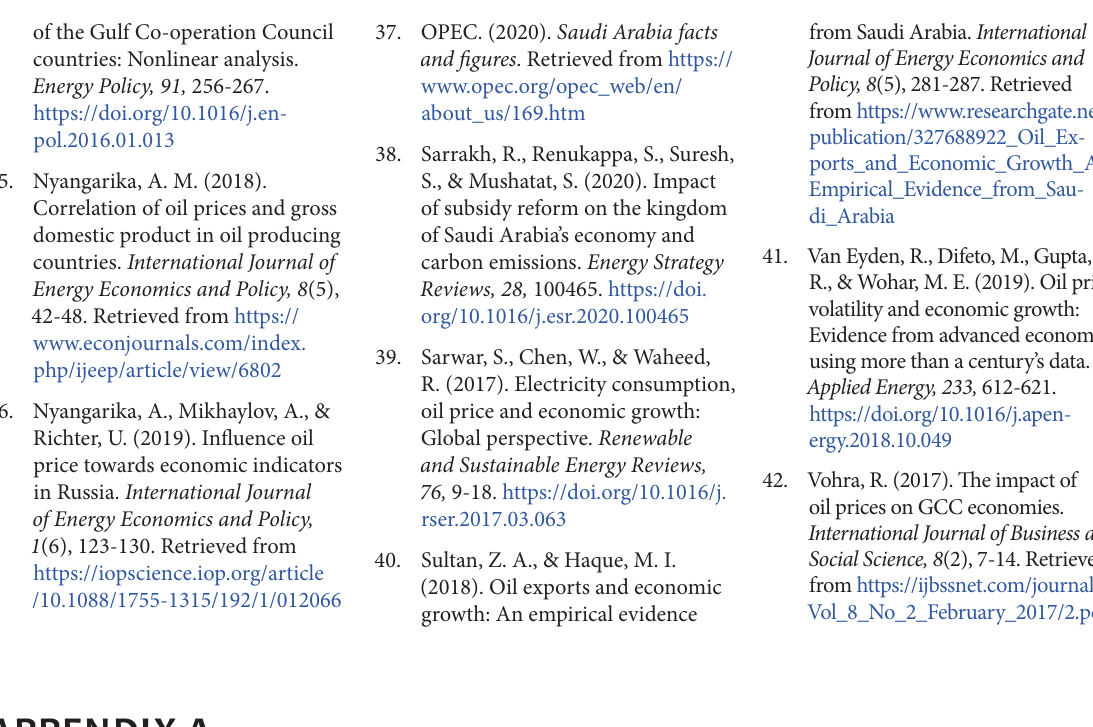
Table A1. FBI of oil prices, oil sector revenue, GDP, and public spending Oil prices